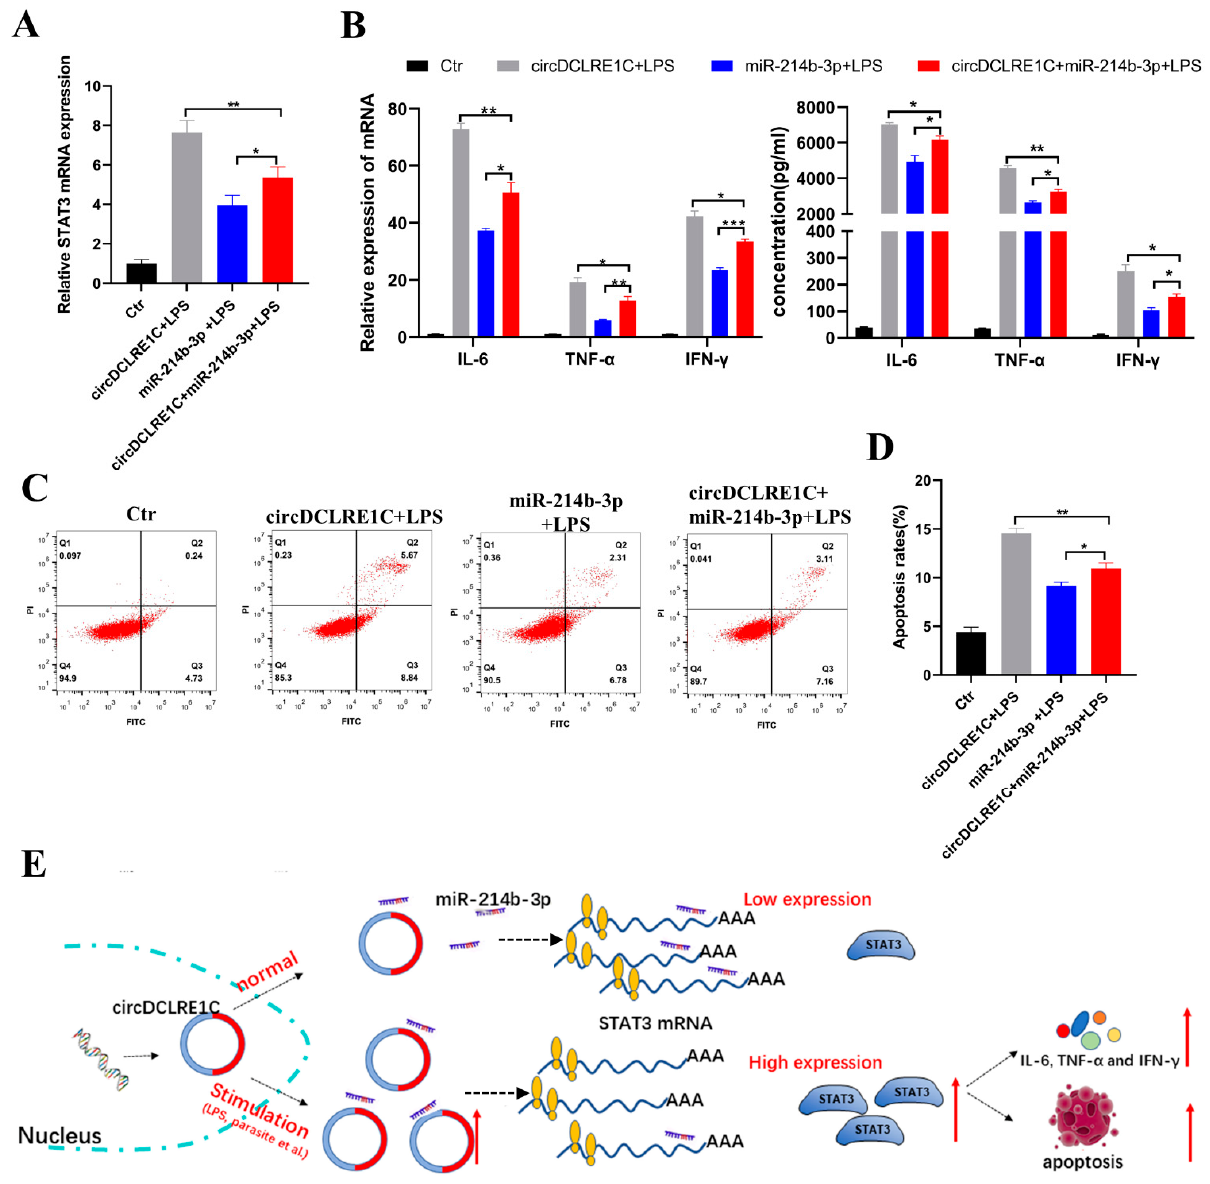
Figure 6. MiR-214b-3p mimics partly reversed the effects of circDCLRE1C in the inflammation re- sponses: ( A ) MiR-214b-3p mimics could rescue the increase in the STAT3 mRNA expression caused by overexpression of circDCLRE1C in HD11 cells stimulated with LPS. ( B ) High expression levels of IL-6, TNF- α , and IFN- γ induced by overexpression of circDCLRE1C were rescued by co-transfection with circDCLRE1C and miR-214b-3p mimics in the inflammatory response. ( C , D ) The Ov-circDCLRE1C- induced increase in cell apoptosis was reversed by co-transfection with ov-circDCLRE1C and miR- 214b-3p mimics. Data are presented as means ± SD ( n = 3 biologically independent samples). * p < 0.05; ** p < 0.01; *** p < 0.001 (Student’s t -test). ( E ) Graphical abstract: graphical diagram of circDCLRE1C promoting LPS-induced inflammation and apoptosis by sponging miR-214b-3p and regulating STAT3